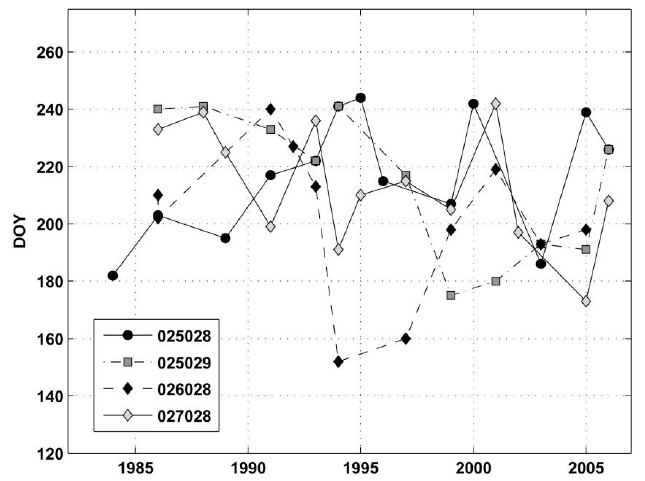
Figure 3. Landsat day of year (DOY) acquisitions by path and row. We used AVHRR data to select peak growing season images with minimum cloud